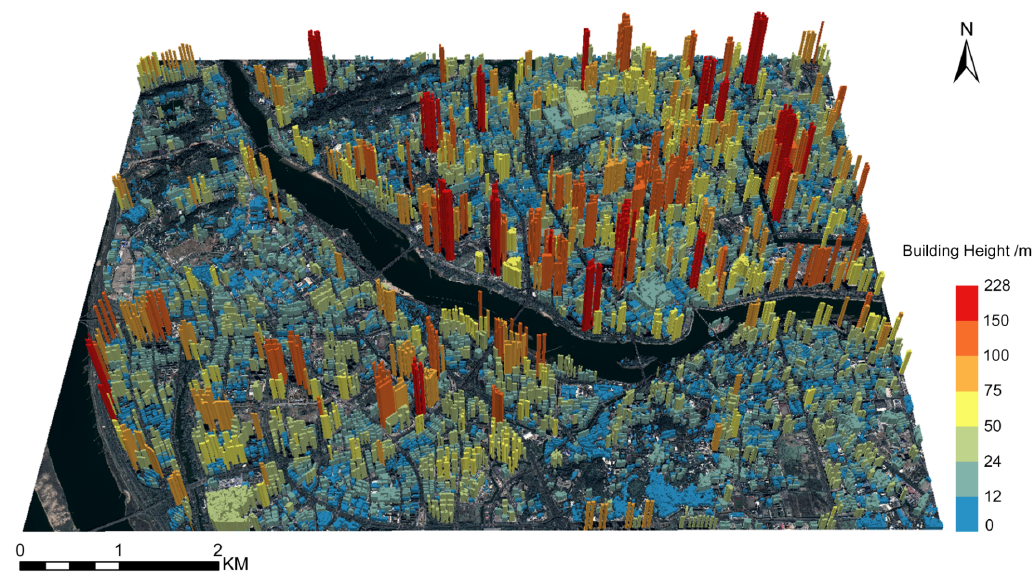
Figure 8. 3D demonstration of estimated building